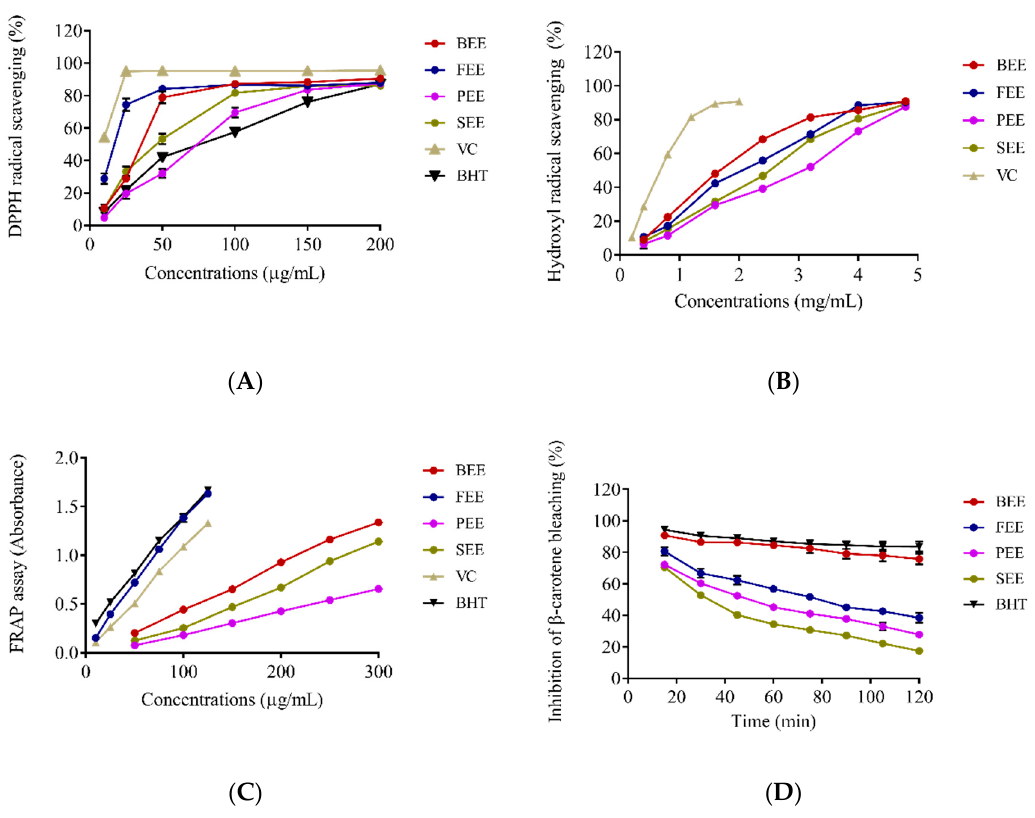
Figure 2. In vitro antioxidant effects of ethanolic extract of Paeonia suffruticosa flowers. Effects of ethanolic extract of P. suffruticosa flowers on DPPH scavenging ( A ), hydroxyl radical scavenging ( B ), FRAP assay ( C ), and inhibition of β -carotene bleaching ( D ). Data were expressed as mean ± SD ( n = 3). VC: vitamin C; BHT: butylated hydroxytoluene; BEE: bud ethanolic extract; FEE: flower ethanolic extract; PEE: petal ethanolic extract; SEE: stamen ethanolic